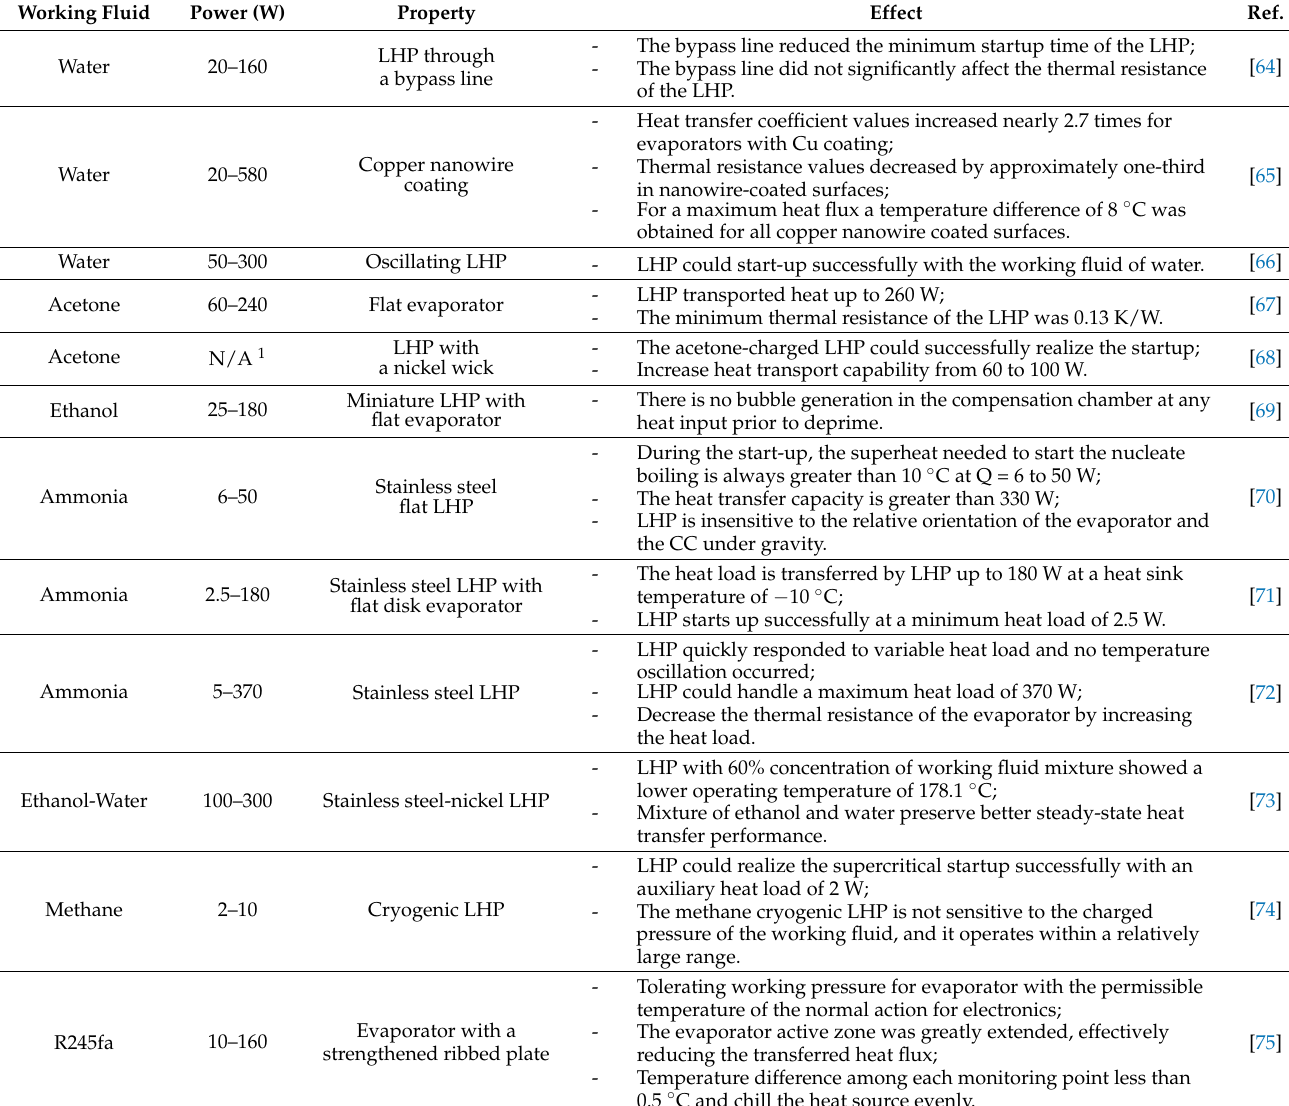
Table 1. Comparison between recent works related to the performance of